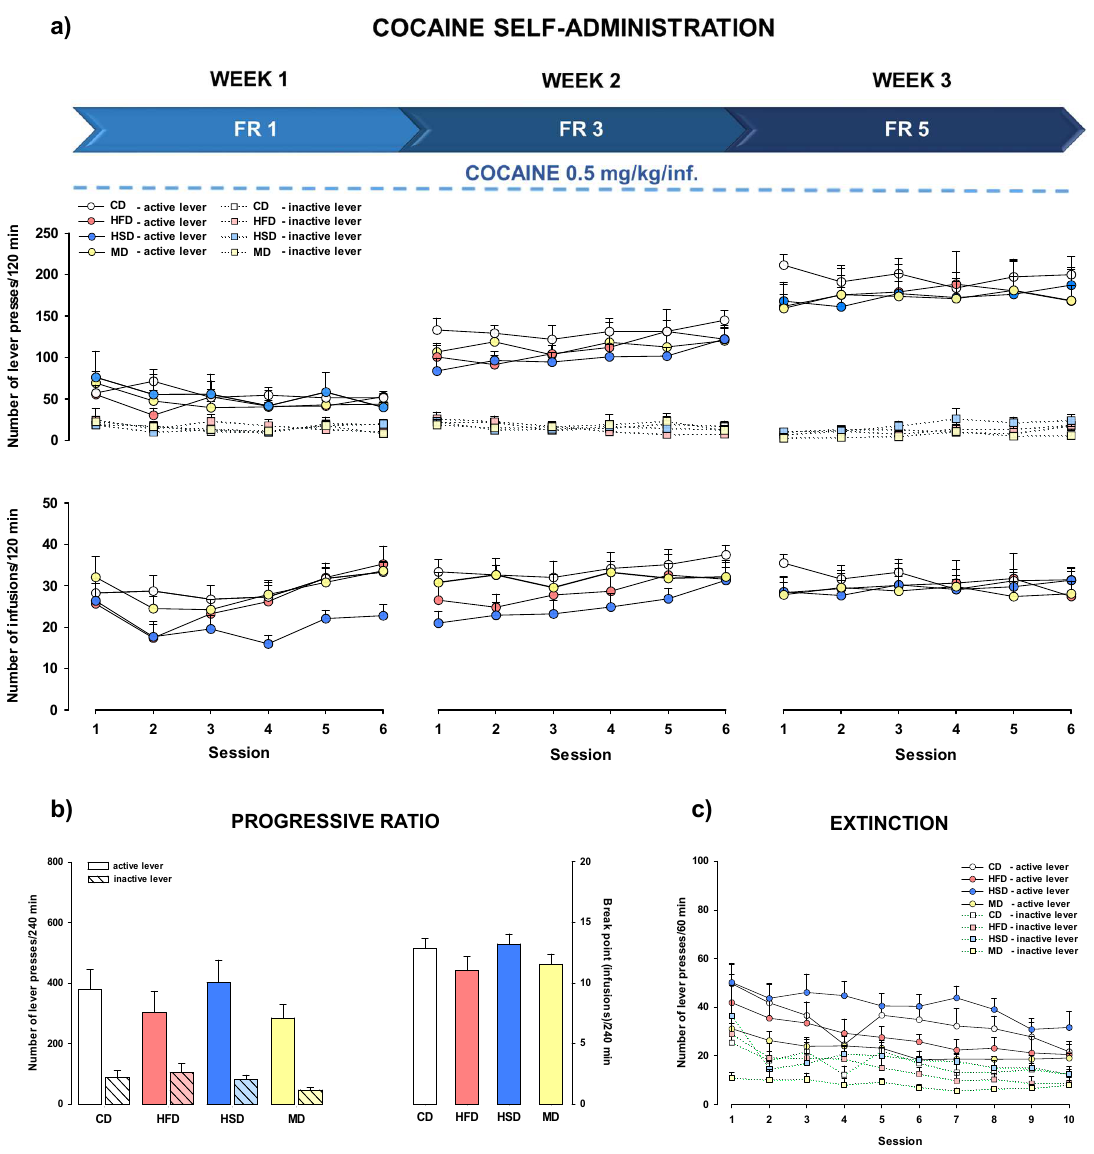
Figure 3. ( a ) E ff ects of a maternal high-fat (HFD), high-sugar (HSD), or mixed (MD) diet during pregnancy and lactation on the acquisition / maintenance of cocaine (0.5 mg / kg / infusion) self-administration with increasing fixed ratio (FR) schedules of reinforcement (FR1–5) in female o ff spring rats. ( b ) E ff ects of the modified maternal diets on cocaine self-administration with a progressive ratio schedule in female o ff spring day after the last session of cocaine self-administration under an increasing schedule of reinforcement (FR1–5) and a stable dose of cocaine (0.5 mg / kg / infusion). ( c ) E ff ects of the modified maternal diets upon self-administration extinction with a fixed dose of cocaine (0.5 mg / kg / infusion) and an increased schedule of reinforcement (FR1–5) in female o ff spring rats. Numbers of active and inactive lever presses and cocaine infusions are expressed as the mean ( ± SEM). The number of animals in each group was as follows: CD ( n = 11), HFD ( n = 10), HSD ( n = 10), MD ( n = 12). CD, control